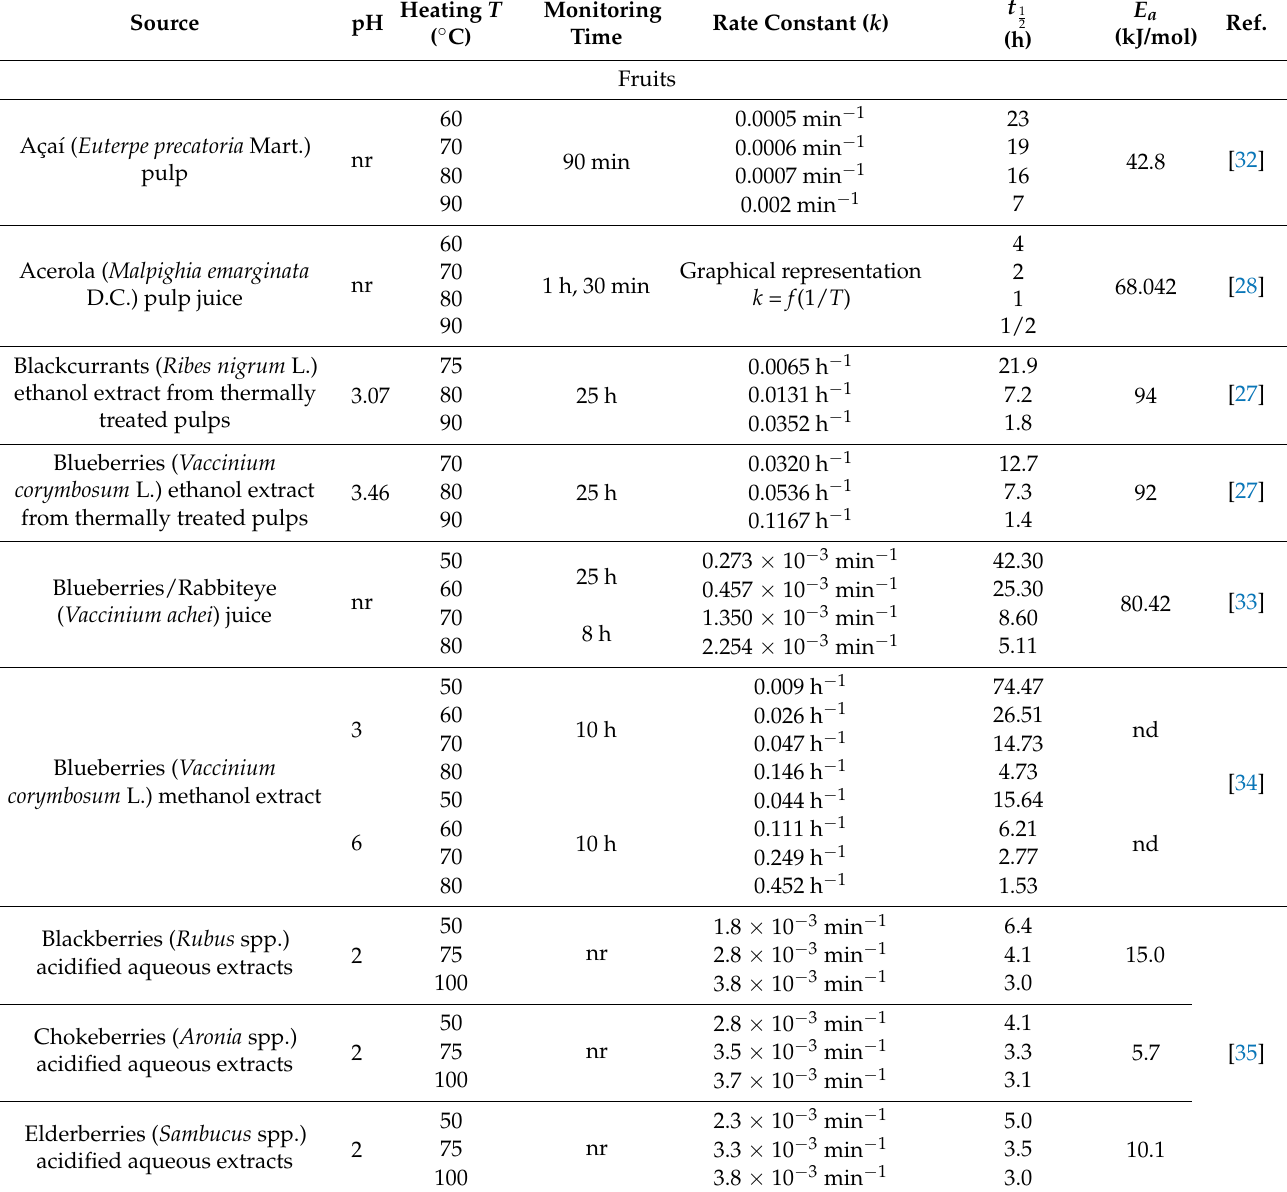
A chemical reaction can be monitored at different temperatures by measuring the content of specific bioactive compounds in a time-dependent way. The Arrhenius plot of Equation (4), lnk vs. 1/ T , allows the prediction of the reaction rate at a given temperature, and the calculation of E a from the slope of the line ( E a /R): the lower the E a , the higher the reaction rate (anthocyanin degradation) and viceversa . Some reported activation energies ( E a ) of anthocyanin degradation during heating at temperatures up to 80, 90 or 100 ◦ C of fruits intended for juice production, are as follow: 94 kJ/mol (blackcurrant), 92 kJ/mol (blueberry), 81 kJ/mol (Maqui), 68.042 kJ/mol (acerola), 66.04 or 55.81 kJ/mol (blood orange), 64.89 kJ/mol (grape), 58.95, 36.99 or 23.96 kJ/mol (blackberry), 42.8 kJ/mol (aça í ), 21.6 kJ/mol (wild strawberry) [10,27–32]. Other values of E a and in addition of k and t 1/2 are presented in Table 1 for a selection of food issues. Most of the published studies were accomplished at temperatures up to 100 ◦ C, under moderately acidic or neutral media. Table 1. Kinetic parameters, rate constant ( k ), half-time ( t 1 ) and activation energy ( E a ) of anthocyanin degradation under 2 various heating conditions, in a selection of fruit, vegetable, flower and colorant products. t 1 E a Heating T Monitoring Rate Constant ( k ) Source pH Ref. 2 ( ◦ C) Time (kJ/mol) (h)